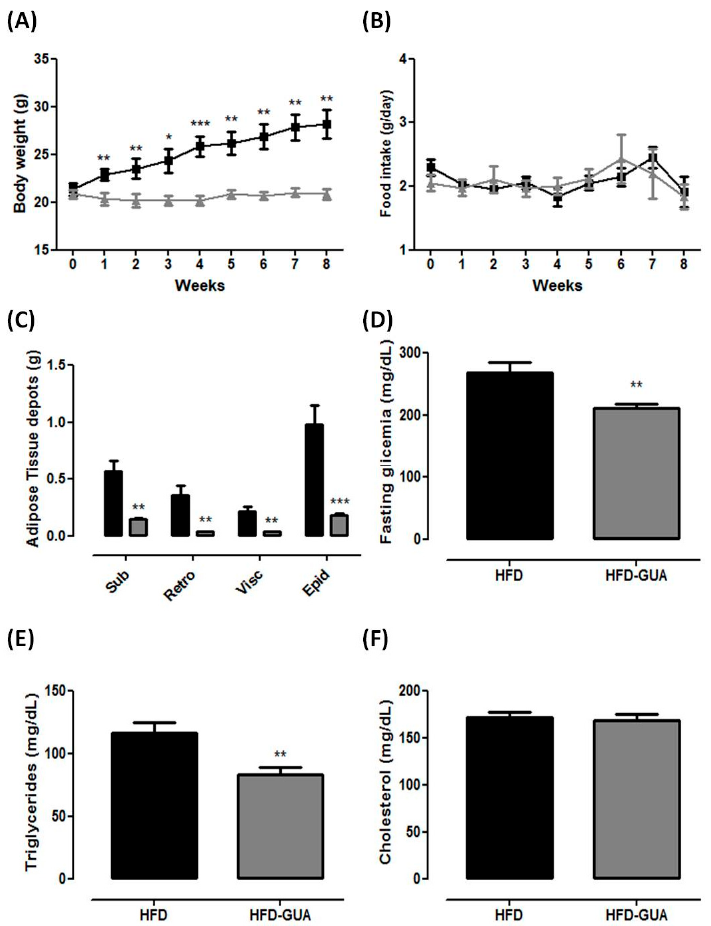
Figure 1. ( A ) Body weight (g) of high fat diet (HFD)-group ( n = 6) and high fat diet + Guarana (HFD-GUA) group ( n = 6) during eight weeks of treatment; ( B ) Food intake (g) of HFD-group ( n = 6) and HFD-GUA group ( n = 6) during eight weeks of treatment; ( C ) Adipose tissue depots (g) of Sub—subcutaneous adipose tisse, Retro—retroperitoneal adipose tissue, Visc—visceral adipose tissue and Epi—epididyimal adipose tissue after eight weeks of treatment; ( D ) Glycemia (mg/dL) after 12 h of fasting; ( E ) Triglycerides (mg/dL) after 12 h of fasting; ( F ) Cholesterol (mg/dL) after 12 h of fasting. Black line/bars correspond to HFD-group ( n = 6) and grey line/bars correspond to HFD-GUA group ( n = 6). * p < 0.05, ** p < 0.01 and *** p < 0.001 when compared with HFD group.